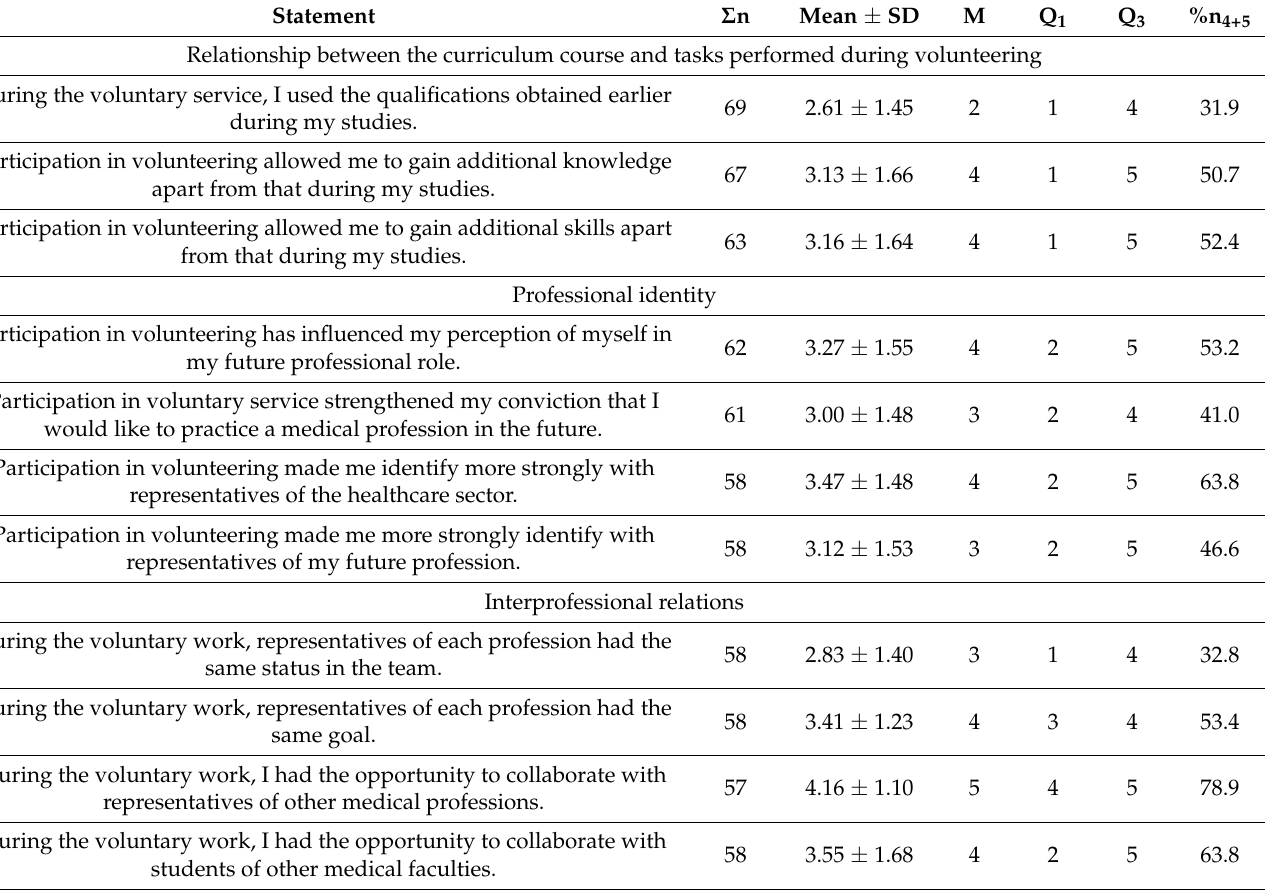
Table 2. Student volunteering in terms of qualifications, professional identity, and interprofessional